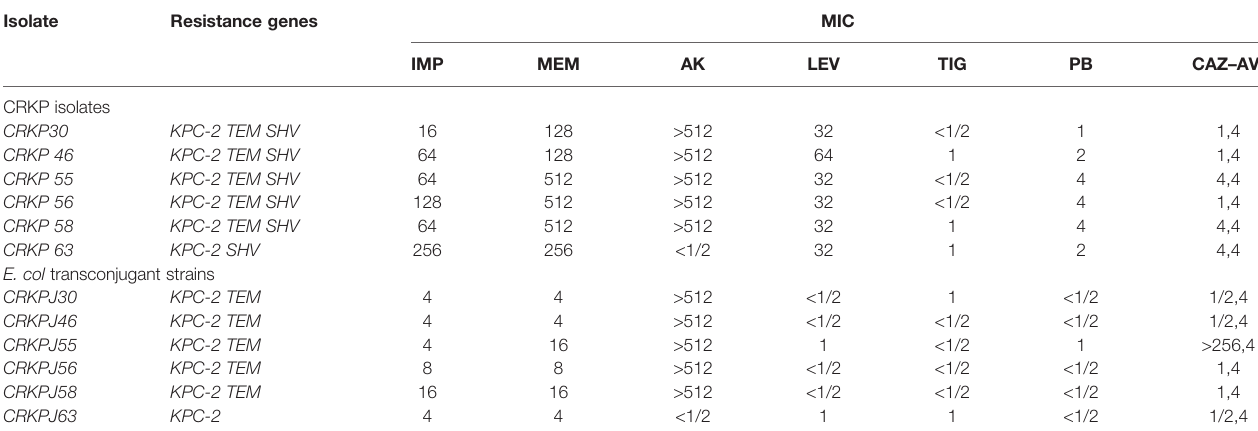
TABLE 2 | Antibiotic susceptibilities of CRKP isolates and their transconjugants (µg/ml). Isolate Resistance genes